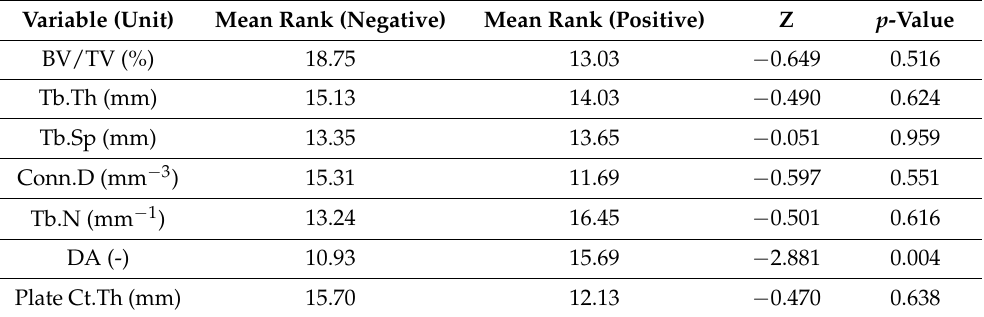
Table 7. Pairwise related-sample Wilcoxon signed-rank test comparing condylar parameter differences. Variable